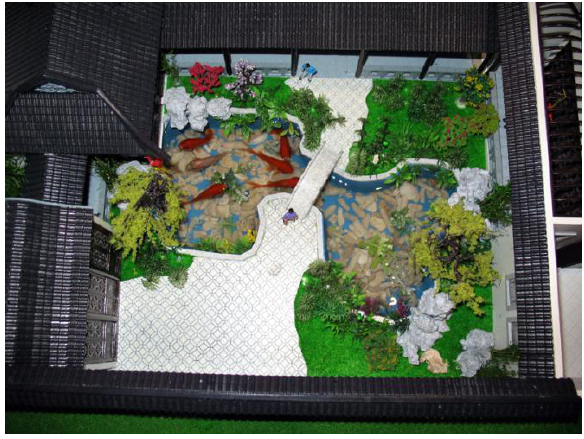
Figure 22. Model of a Suzhou Fuyuan traditional courtyard garden with fish pond and circulation corridor, Suzhou 7th Housing Exhibition. Photo: Donia Zhang